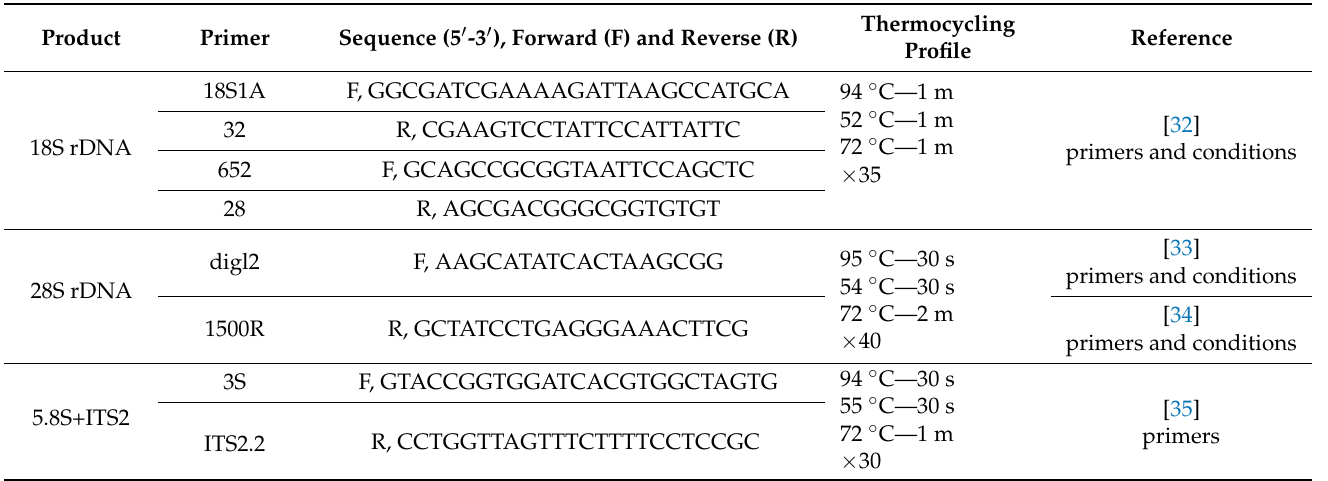
Table 3. PCR primers and thermocycling conditions; in all reactions, initial denaturation was at 95 ◦ C for 5 min and final extension was at 72 ◦ C for 10